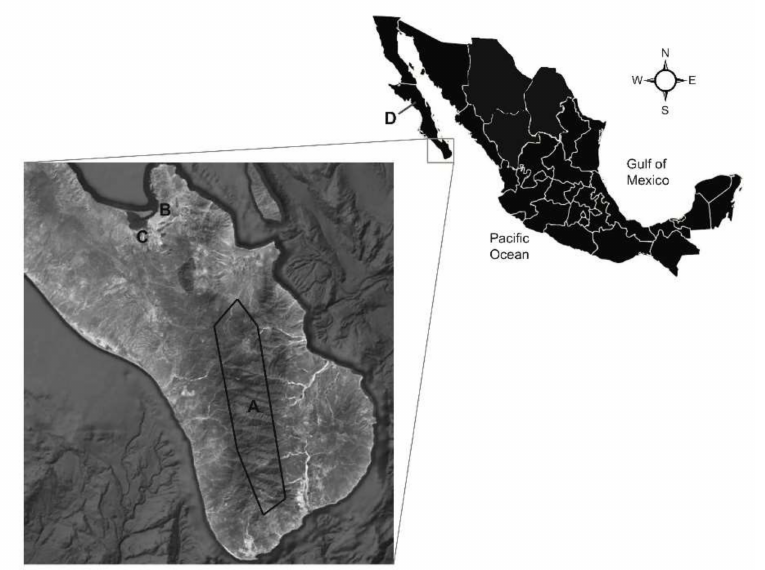
Figure 1. Collecting sites. Canthon ( Bajacanthon ) is distributed at the southernmost part of the Baja California Peninsula, Mexico. A, Sierra La Laguna mountain range; B, Cerro el Mesquitito; C, La Paz City; D, El Juncalito in the Sierra de la